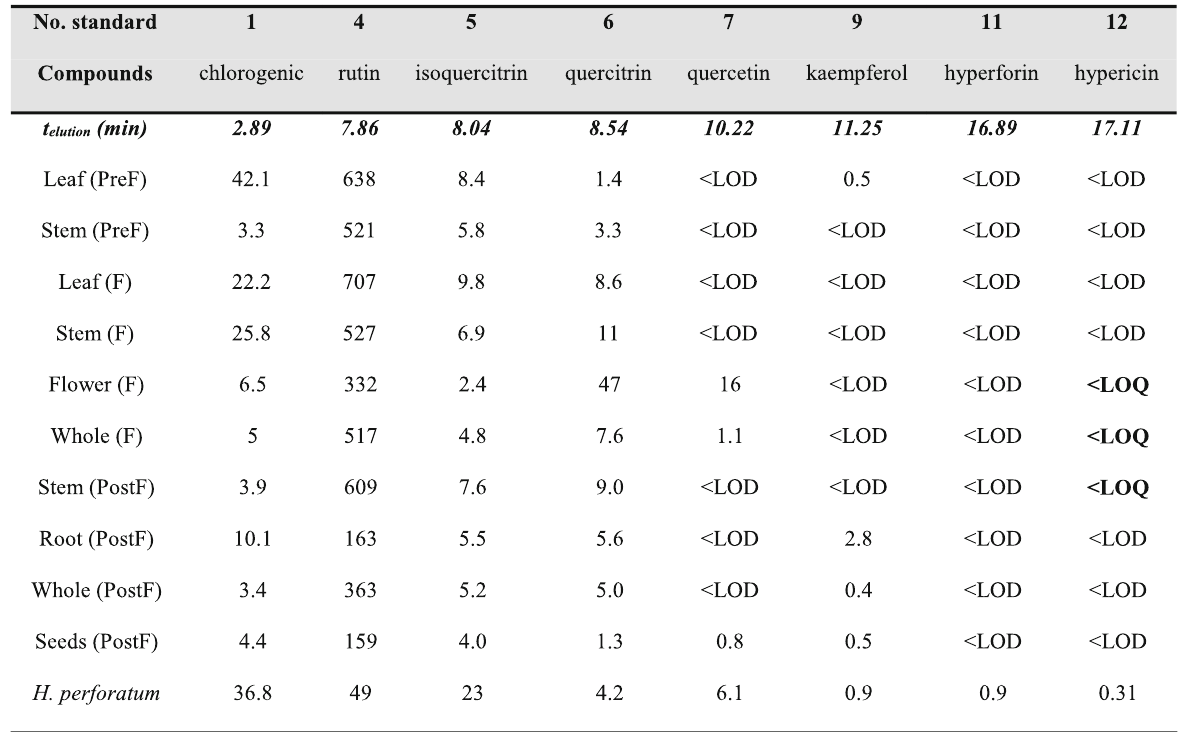
Table 2 Elution time (in minutes), found concentrations ( μ g/mg, dried weight) for the tested standards in the studied samples for different parts of the H. capitatum at pre-flowering (PreF), flowering (F) and post-flowering (PostF) stages. The other standards (2, 3, 8, 10, Fig. 2) are all bellow